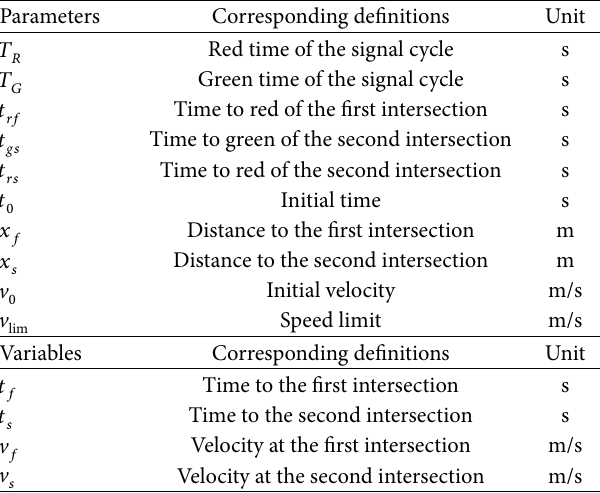
Figure 4: Two stages of speed optimization problem. Table 1: Parameters/variables and corresponding